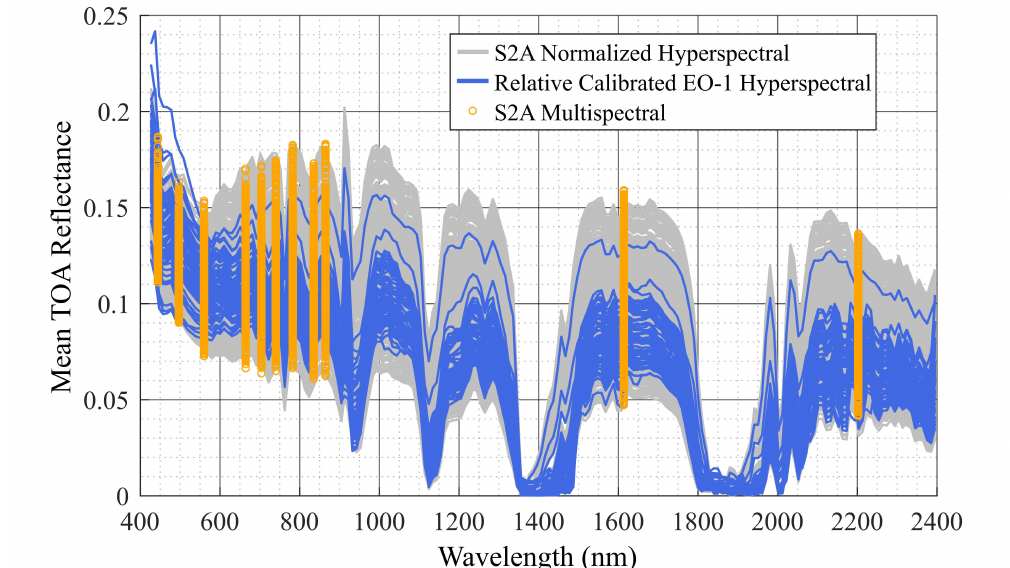
Figure 15. S2A-normalized hyperspectral TOA reflectance (grey line), EO-1 hyperspectral TOA reflectance after relative gain correction (blue line), and S2A multispectral TOA reflectance (orange